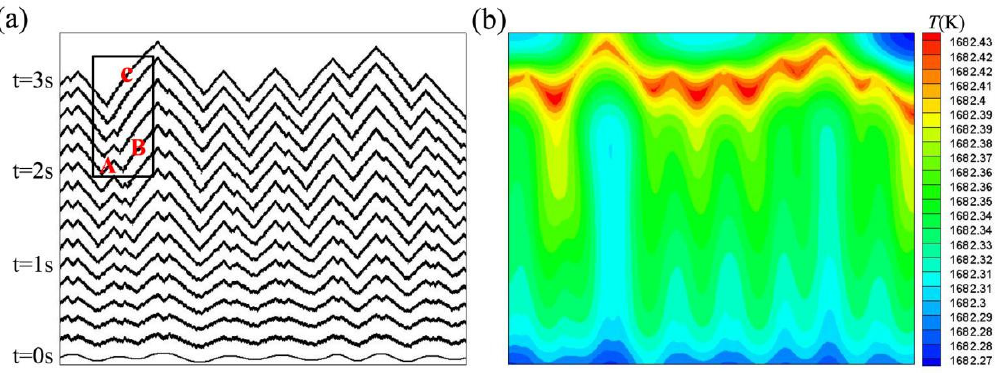
Figure 5. ( a ) Evolution of interface morphologies at v e = 153 µ m/s; the time interval is 0.2 s; ( b ) the corresponding temperature field at 3 s.